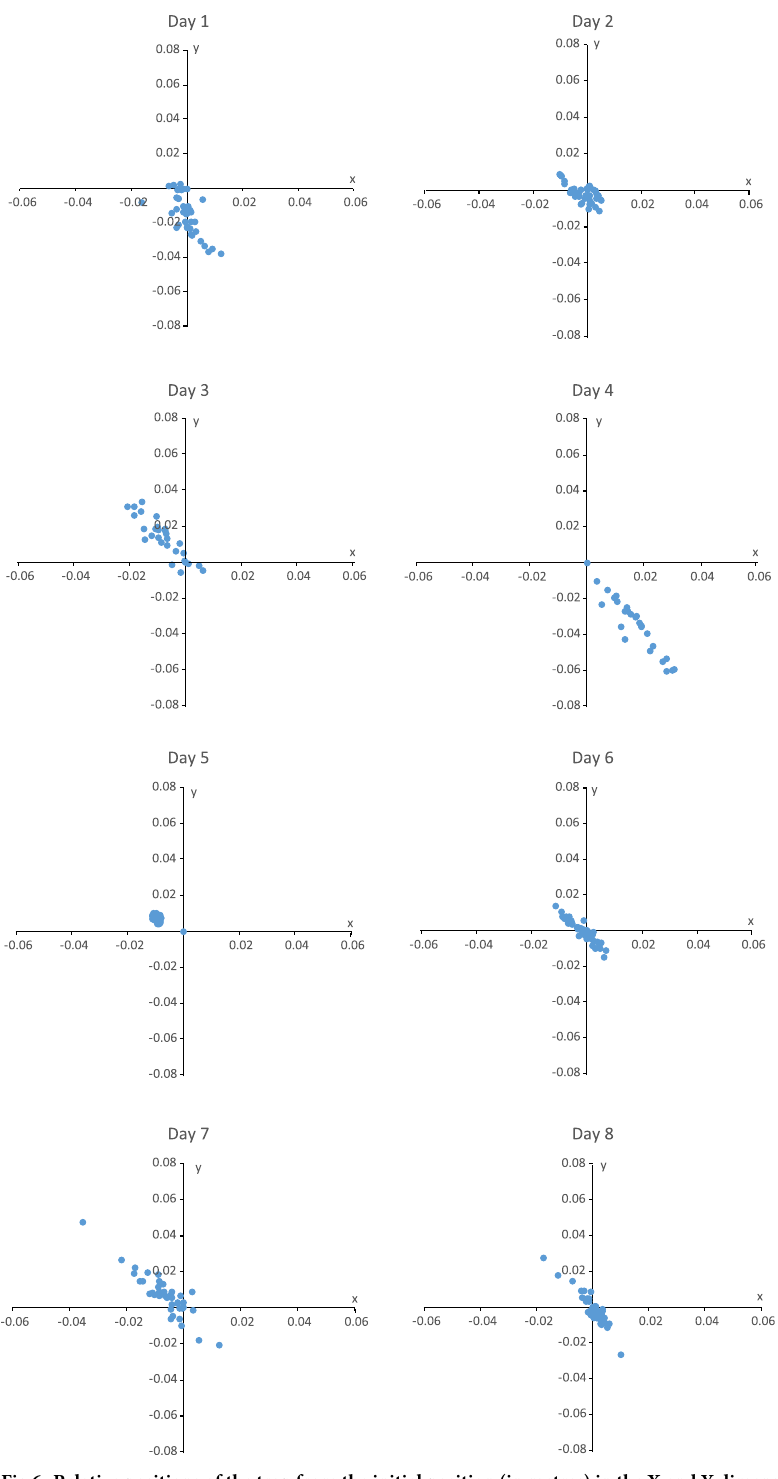
Fig 6. Relative positions of the trap from the initial position (in metres) in the X and Y dimensions.